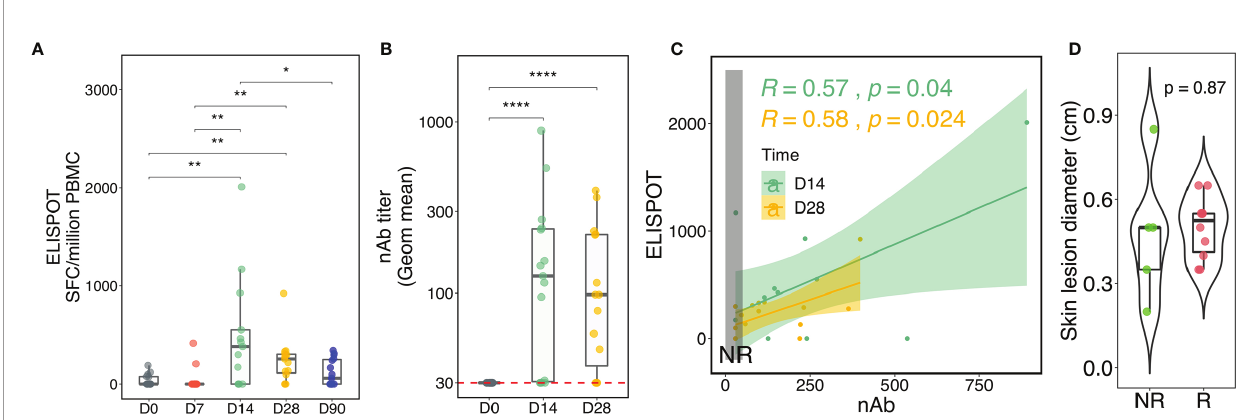
FIGURE 2 | Kinetics of the vaccinia-speci fi c T-cell response, neutralizing antibody (nAb) titer, and skin lesion after the recombinant Tiantan vaccinia-based HIV-1 vaccine (rTV/HIV-1) booster vaccination. (A) Vaccinia virus-speci fi c T-cell responses as assessed by enzyme-linked immunospot (ELISpot). Individual values are presented in box plots . SFCs , spot-forming cells. (B) Kinetics of the nAb response to the vaccinia virus. (C) Correlations between the vaccinia-speci fi c ELISpot responses and the nAb titers on days 14 and 28. Light green and light mustard shading indicate the 95% con fi dence intervals of the two trend lines. The vertical dark grey rectangle encloses responses for non-responders (NRs). (D) Skin lesion diameter at the inoculation site as measured 1 week after rTV/HIV-1 booster vaccination. For all, p -values for signi fi cant difference between two given time points were calculated using the Wilcoxon test. *P < 0.05, **P < 0.01, ****P <